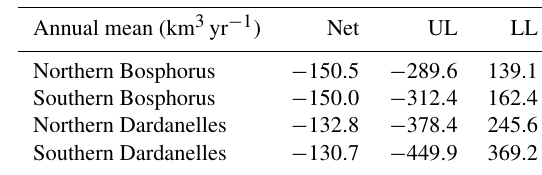
Table 4. Annual mean of net, upper layer and lower layer volume fluxes (km 3 yr − 1 ) for the whole simulation period. A negative value indicates the flux is in the Black Sea – Aegean Sea